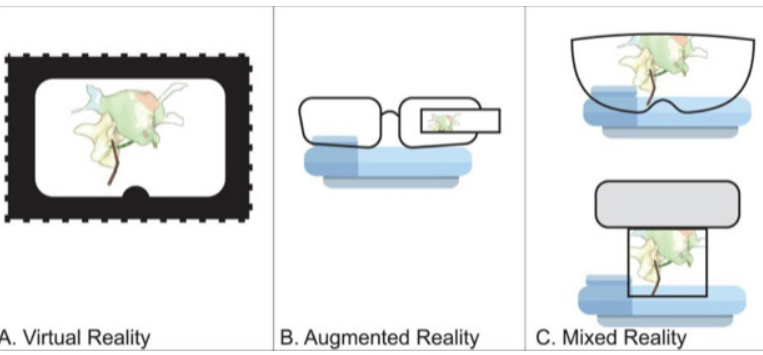
Fig. 2 - Schematic display of extended realities. A) Virtual reality: digital space is completely separated from the environment. B) Augmented reality: digital space is integrated into the users’ natural environment. C) Mixed reality: the user is able to stay in his natural environment and still interact with the digital